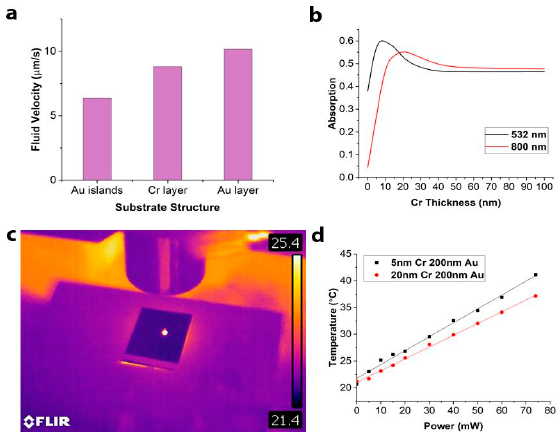
Figure 2. The substrate optimization. ( a ) COMSOL simulations were conducted to evaluate the most efficient substrate structure. ( b ) Finite difference time domain (FDTD) simulation results for substrate absorption optimization for 532 and 800 nm wavelengths varying chromium thickness from 0 to 100 nm while holding gold thickness constant at 200 nm. ( c ) FLIR IR camera imaging was used to measure the maximum temperature in a 1 µ L drop of fluid. ( d ) Experimentally measured temperature increase while testing two substrates with 532 nm light with power ranging from 0 to 80